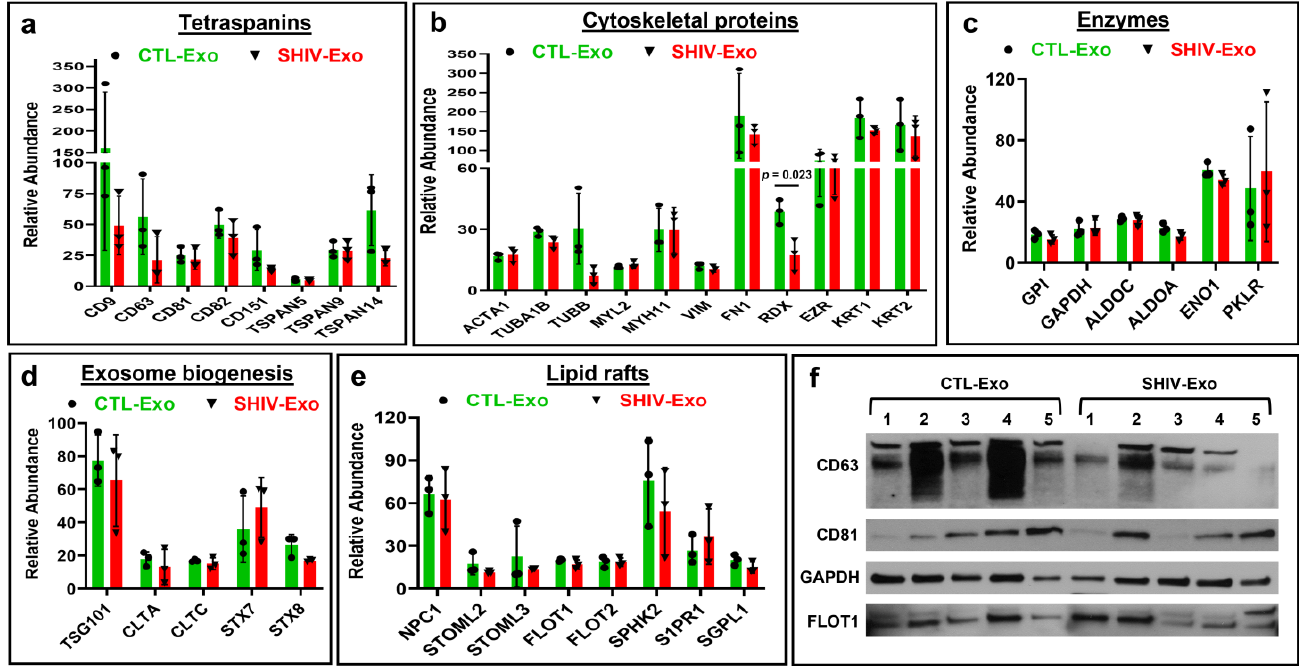
Figure 3. Hallmark exosomal proteins quantified by proteomic analysis in circulating exosomes of SHIV-infected and uninfected RM. ( a – e ) Relative abundance of quantified proteins in CTL-/SHIV- Exo. Proteins that exhibited group differences shown as bar graphs with green and red for CTL-Exo and SHIV-Exo, respectively. Plasma exosomes were isolated from three SHIV-infected and three uninfected RM (N = 3/group). Graphs show mean ± SD of relative abundance that was calculated from four experimental replicates of each sample. Protein group ‘b’ and ‘e’ passed the D’Agostino and Pearson normality test and protein group ‘c’ and ‘d’ passed the Shapiro–Wilk normality test. Protein group ‘a’ did not pass the normality test. The data sets were followed by unpaired t test with Welch correction, performed for normally distributed data. When the data did not pass the normality test, a non-parametric Mann–Whitney test was performed. Significant differences ( p < 0.05) between groups are indicated. ( f ) The expression of CD63, CD81, GAPDH, and FLOT1 in CTL-/SHIV-Exo was further validated by Western blotting (N = 5/group). The protein coding gene names are presented here and were also described in the text. CTL-Exo: Plasma exosomes isolated from uninfected RM; SHIV-Exo: Plasma exosomes isolated from SHIV-infected